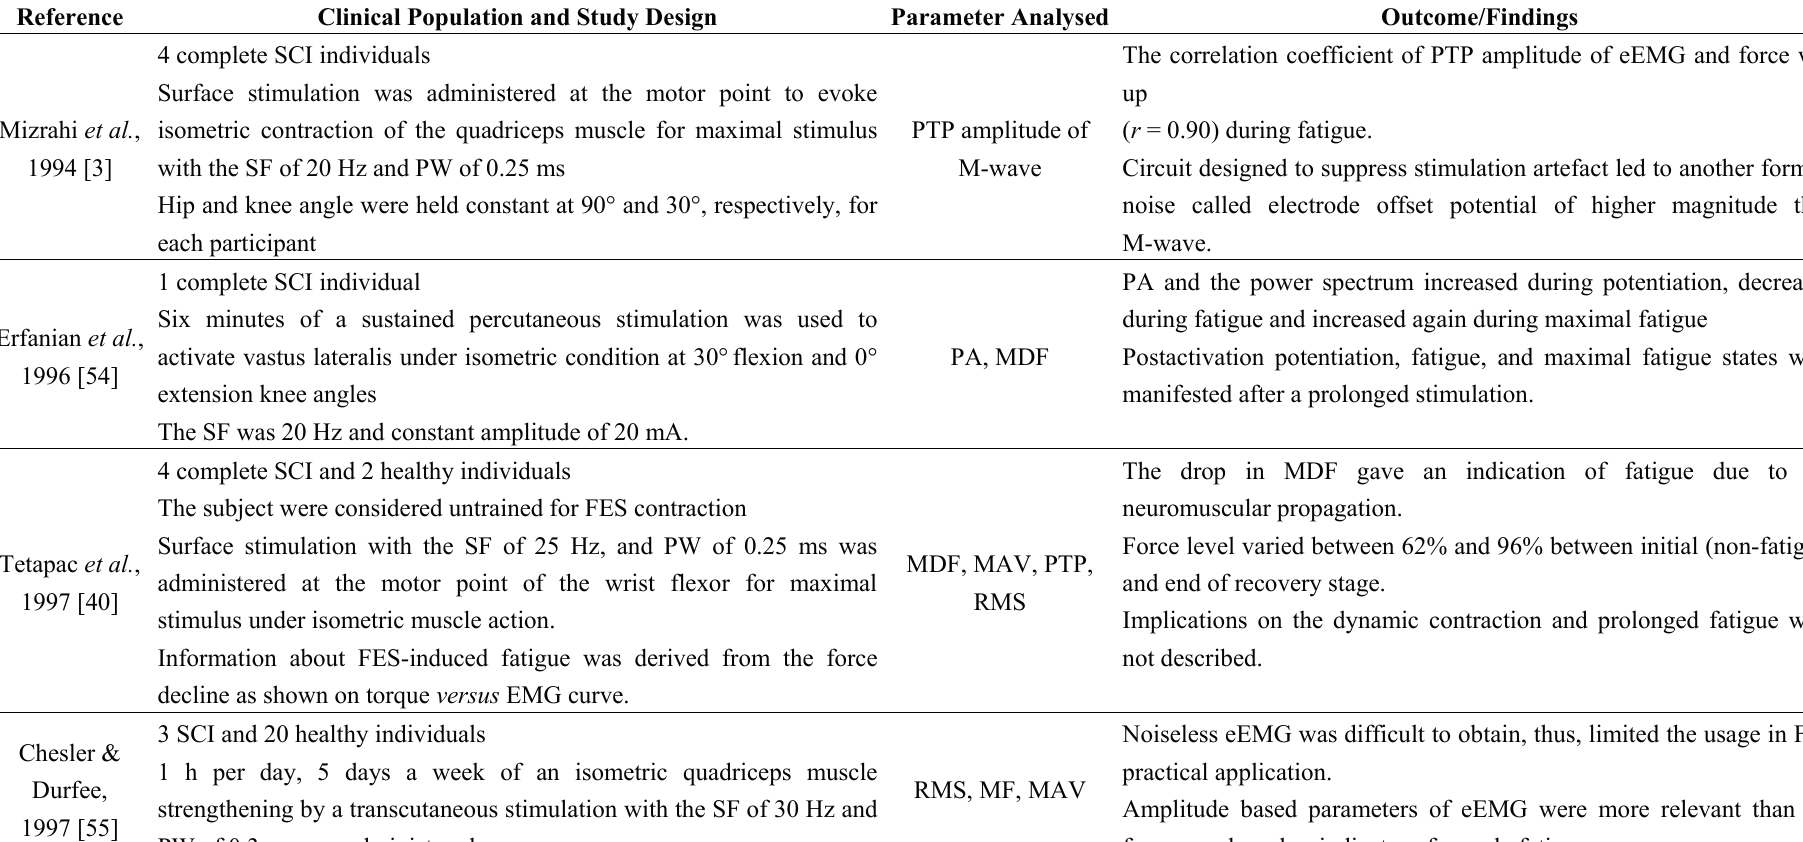
Table 2. Summary of studies on electrically evoked contraction and evoked EMG-fatigue